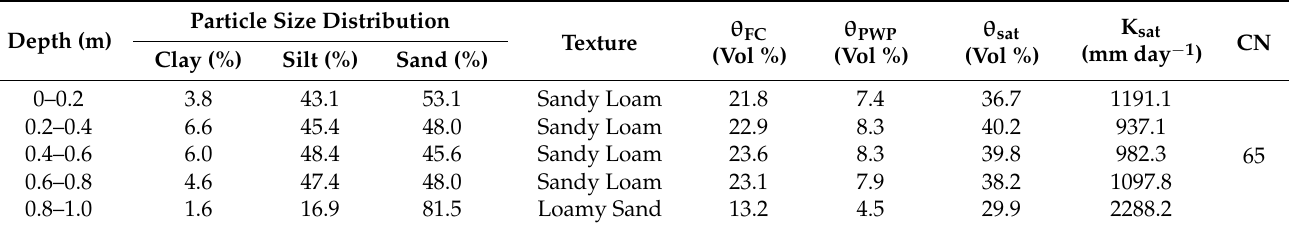
Table 2. Soil physical characteristics of the experimental site.